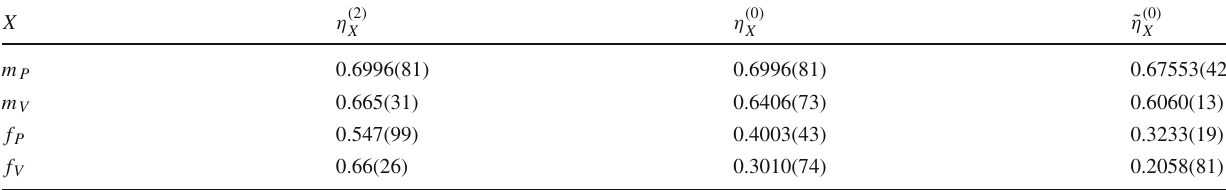
( 2 ) = η ( 0 ) m P m P because of the matching condition (B.2)